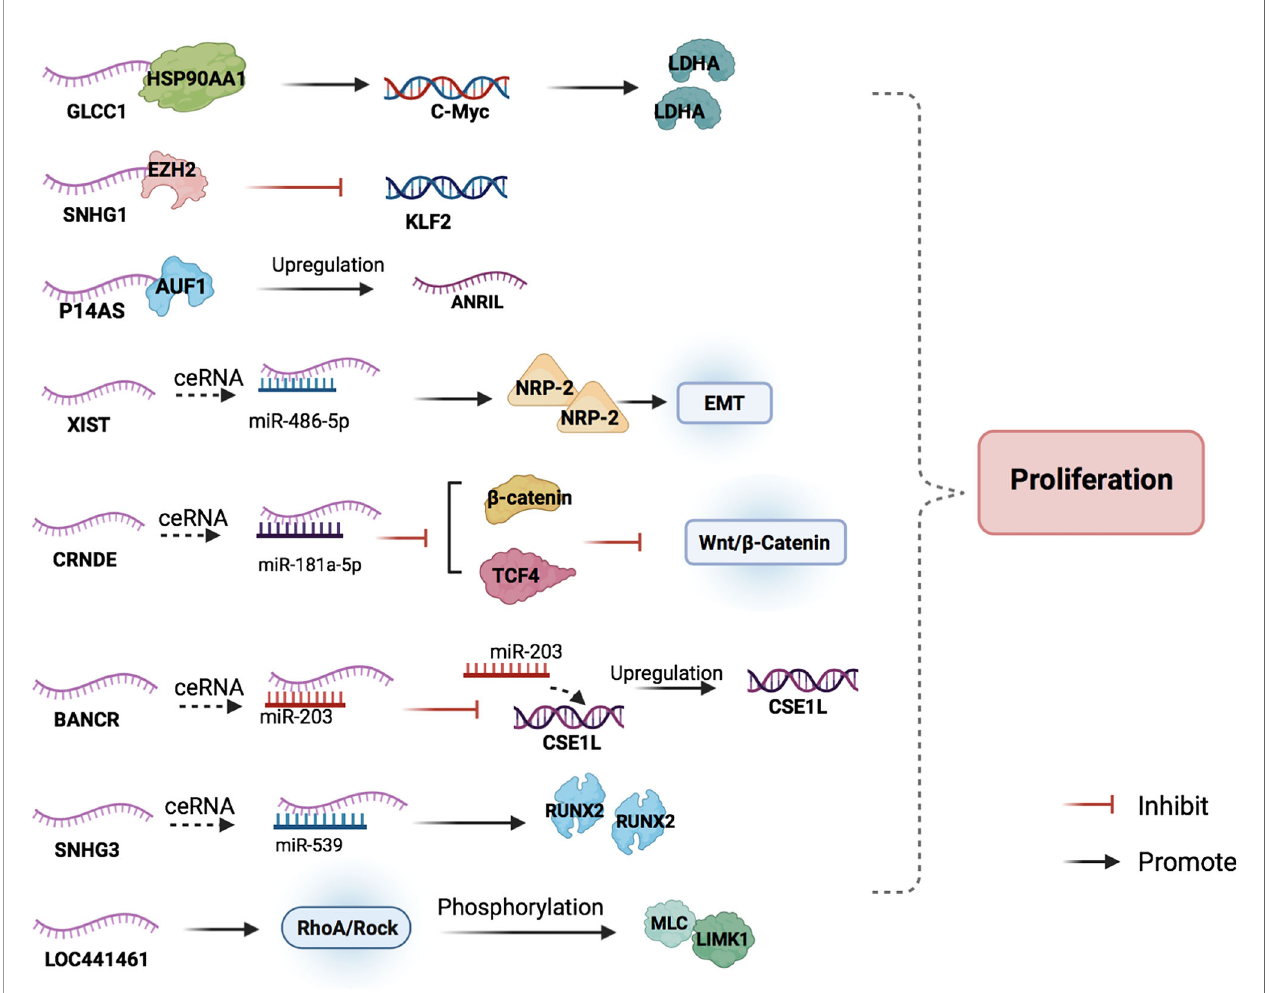
FIGURE 2 | The main mechanisms of lncRNAs in CRC cell proliferation. LncRNAs participate in the CRC cell proliferation by combining with proteins to regulate the target downstream, acting as miRNA sponges, and blocking cell cycle